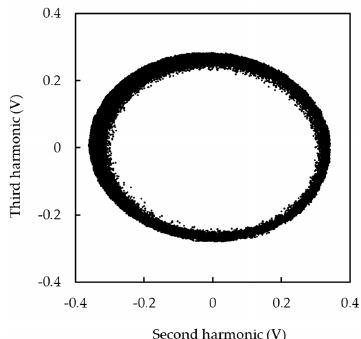
Figure 2. Lissajous diagram using second and third harmonics.